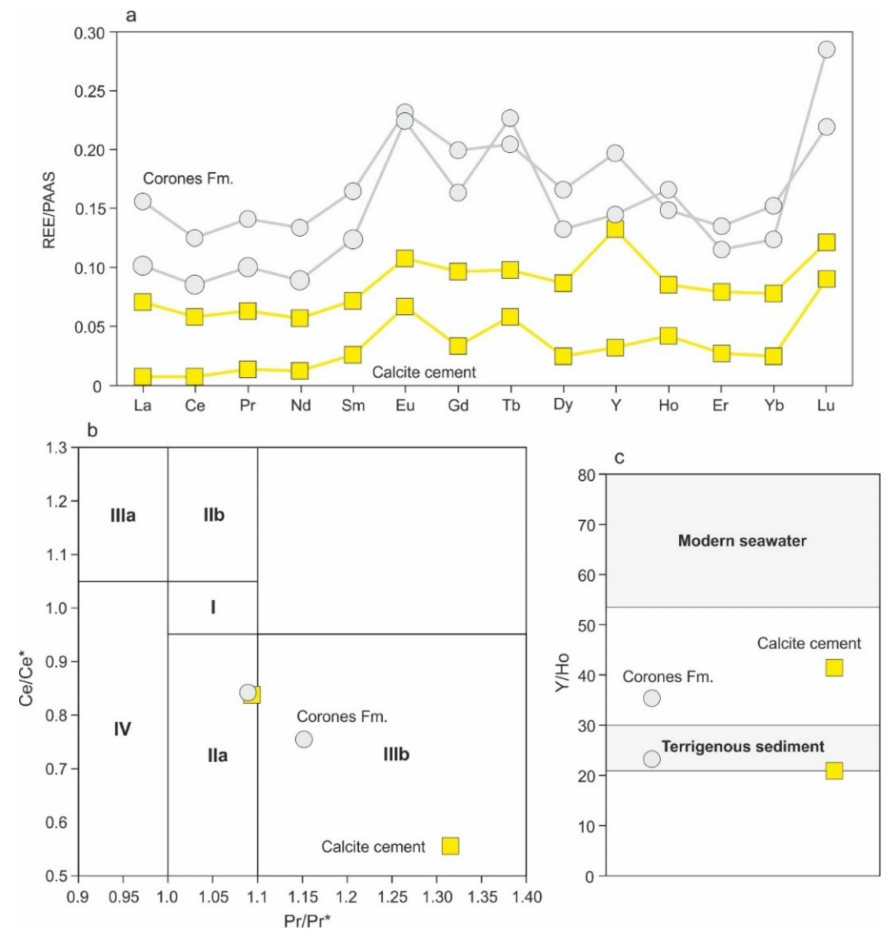
Figure 12. ( a ) PAAS-normalized REEs + Y distribution patterns of the Corones Formation and bladed calcites. ( b ) Ce / Ce* vs. Pr / Pr* cross-plot showing the Ce and Pr anomalies of the Corones Formation and bladed calcites. The method of Reference [92] modified by Reference [93] is used. Field I: neither Ce nor La anomaly; field IIa: positive La anomaly and no Ce anomaly; field IIb: negative La anomaly and no Ce anomaly; field IIIa: positive Ce anomaly; field IIIb: negative Ce anomaly; field IV: positive Ce and La anomalies. ( c ) Y / Ho ratios the Corones Formation and bladed calcites. Y / Ho limits for modern seawater and terrigenous sediments are based on References